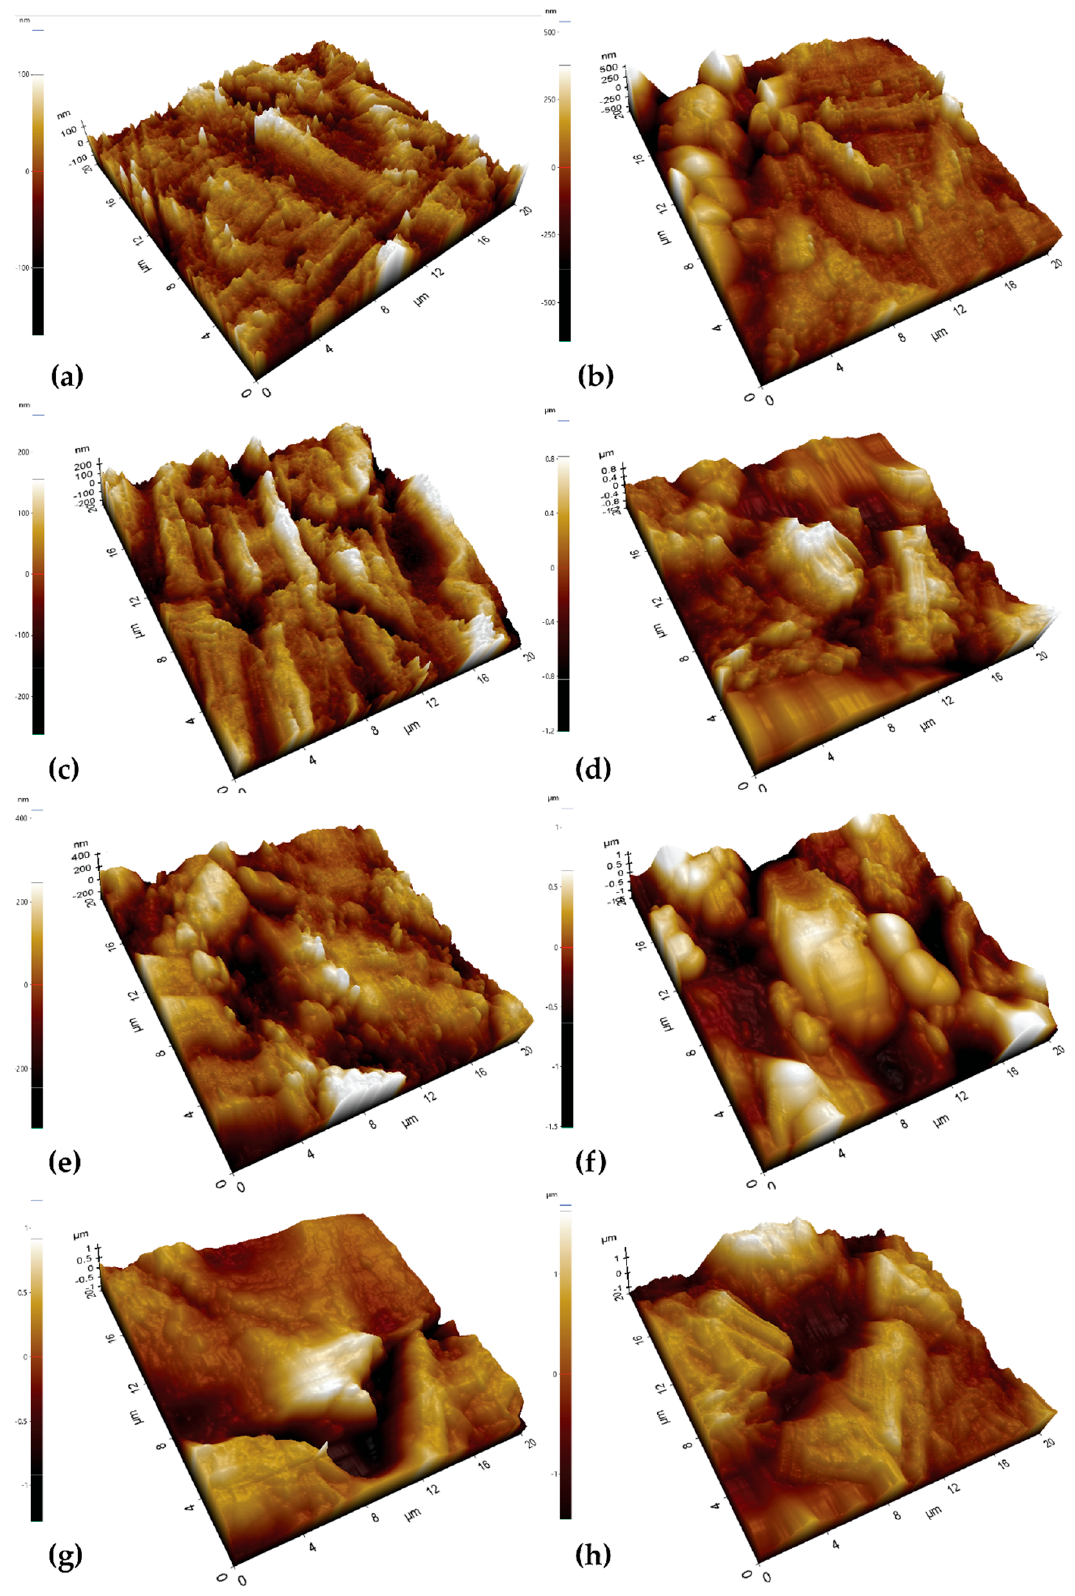
Figure 12. AFM images of a fractured 2 mm Al7075 FSW specimens: ( a ) Pin3 1000 rpm 80 mm/min; ( b ) Pin3 1000 rpm 300 mm/min; ( c ) Pin3 2000 rpm 400 mm/min; ( d ) Pin3 2000 rpm 800 mm/min; ( e ) Pin4 1000 rpm 80 mm/min; ( f ) Pin4 1000 rpm 300 mm/min; ( g ) Pin4 2000 rpm 400 mm/min; ( h ) Pin4 2000 rpm 800 mm/min.